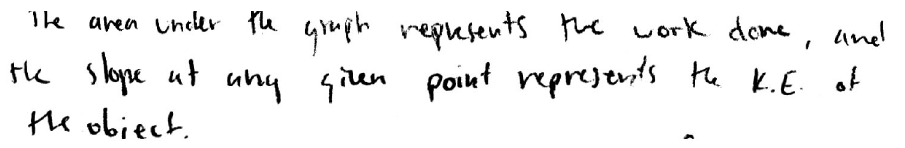
FIG. 11. Example of explanation when interpreting the force-position graph.